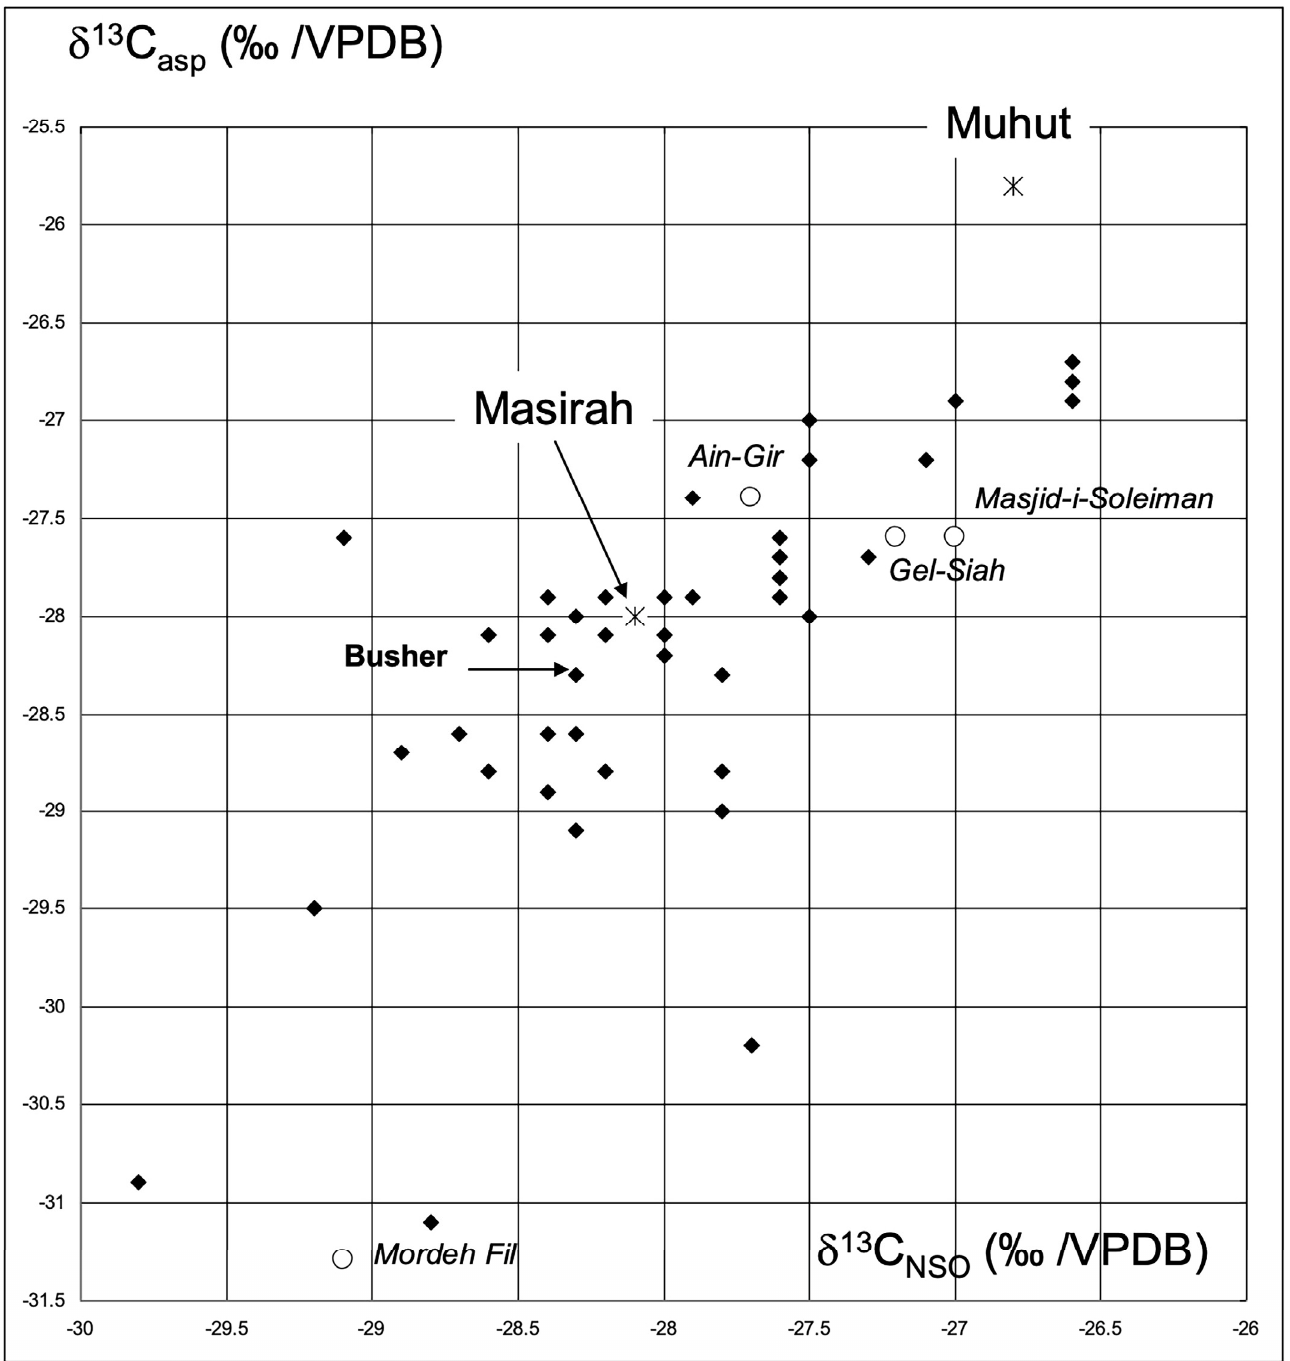
Figure 9. Plot of δ 13 Casp (‰/VPDB) vs. δ 13 CNSO (‰/VPDB) from Muhut and Masirah bitumens: comparison with data from other archaeological sites and from four oil seeps of Iran. The archaeological sites are: Thaj (Saudi Arabia), Phanom-Surin (Thailand), Busher (Iran).